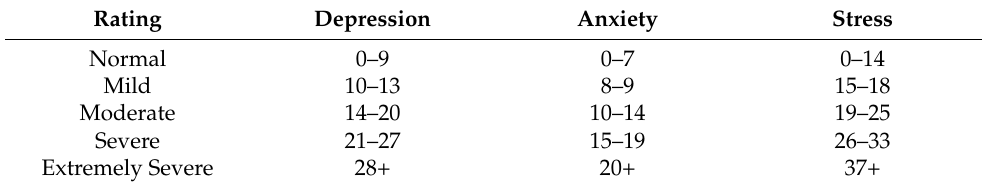
Table 1. Severity scores of depression, anxiety, and stress